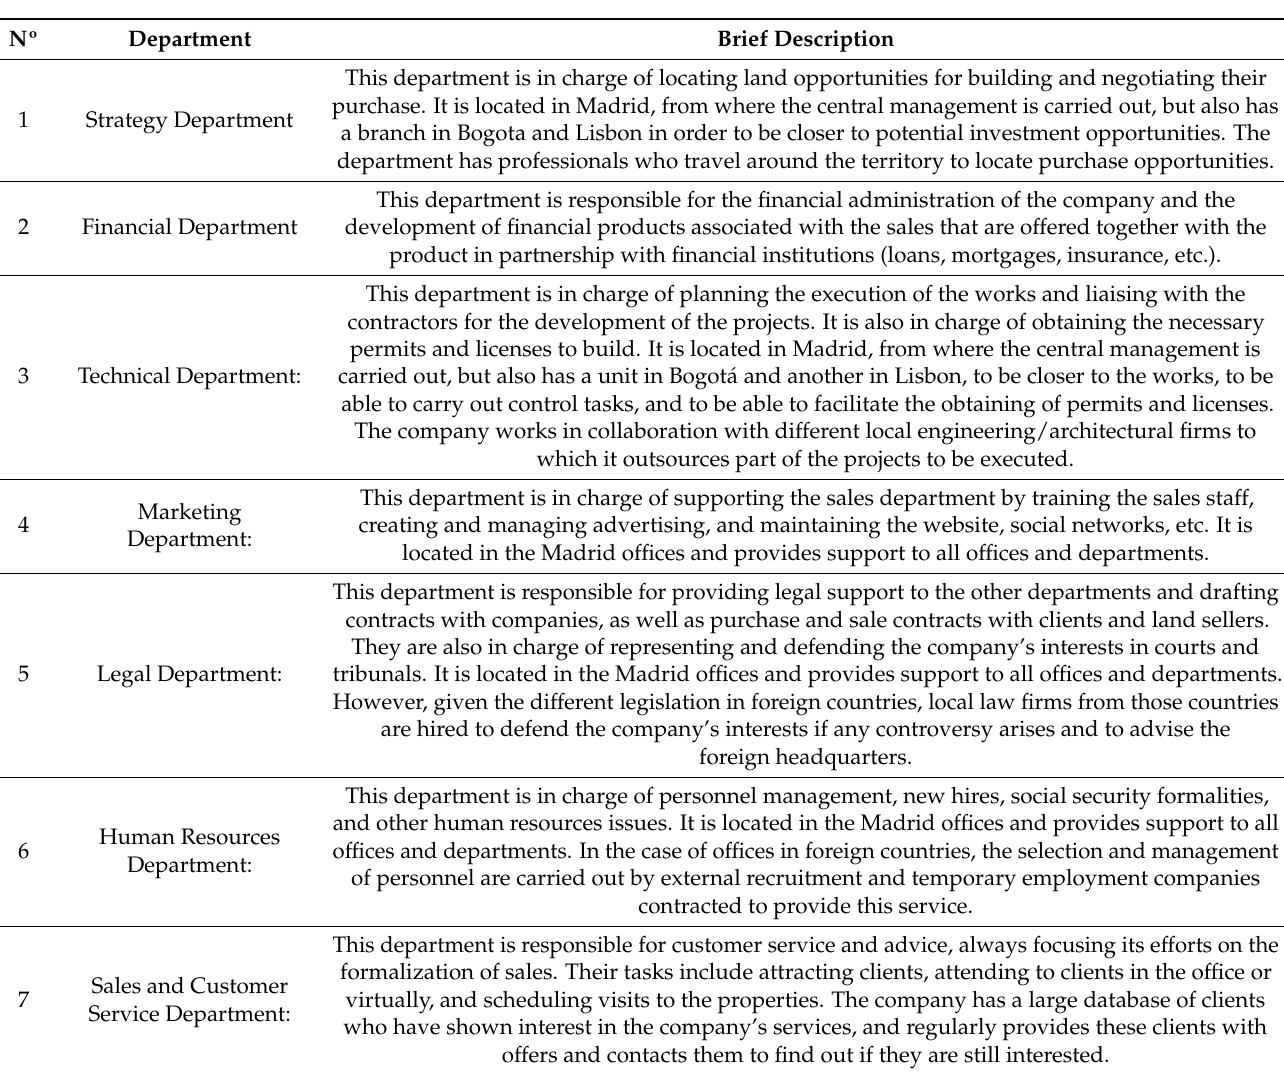
Table 2. Department to be assigned to each working